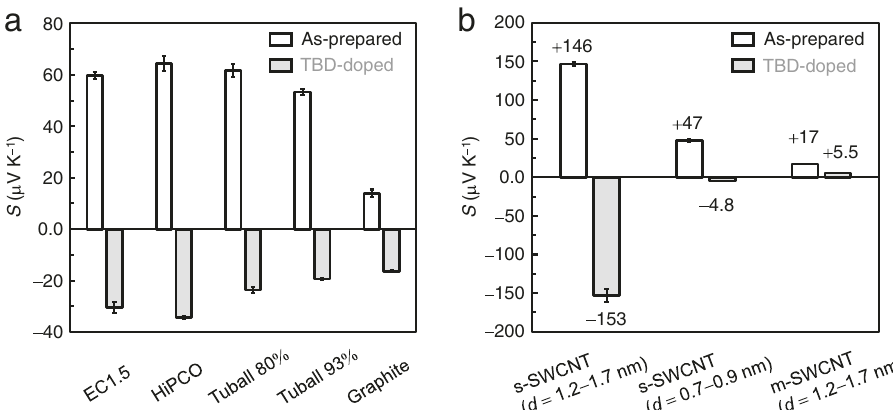
Fig. 5 Feasibility of TBD doping on different nanoscale carbon materials in term of Seebeck coef fi cient ( S ) measured at room temperature (~298 K) in air. a Variations in Seebeck coef fi cient of different nanoscale carbon materials. Doping was performed using DMF solution of TBD (71 mM). The doping condition was the same as that for single-walled CNTs synthesized using the eDIPS method (EC1.5, Meijo Nano Carbon), which is described in detail in METHOD section. The percentages (80% and 93%) of the Tuball CNTs indicate purity of the pristine materials. Data statistics: n ≥ 3. Error bards indicate (SD). b Variations in Seebeck coef fi cient according to the conducting type of SWCNTs. Data statistics: n = 3. Error bars indicate the corresponding SDs.